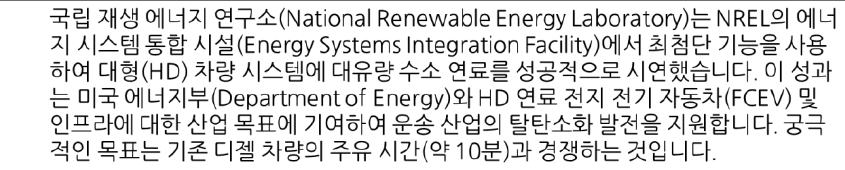
Figure 10. An example of the text translation process followed by an executive summary. The paragraph of the last step is the translation from English to Korean version.